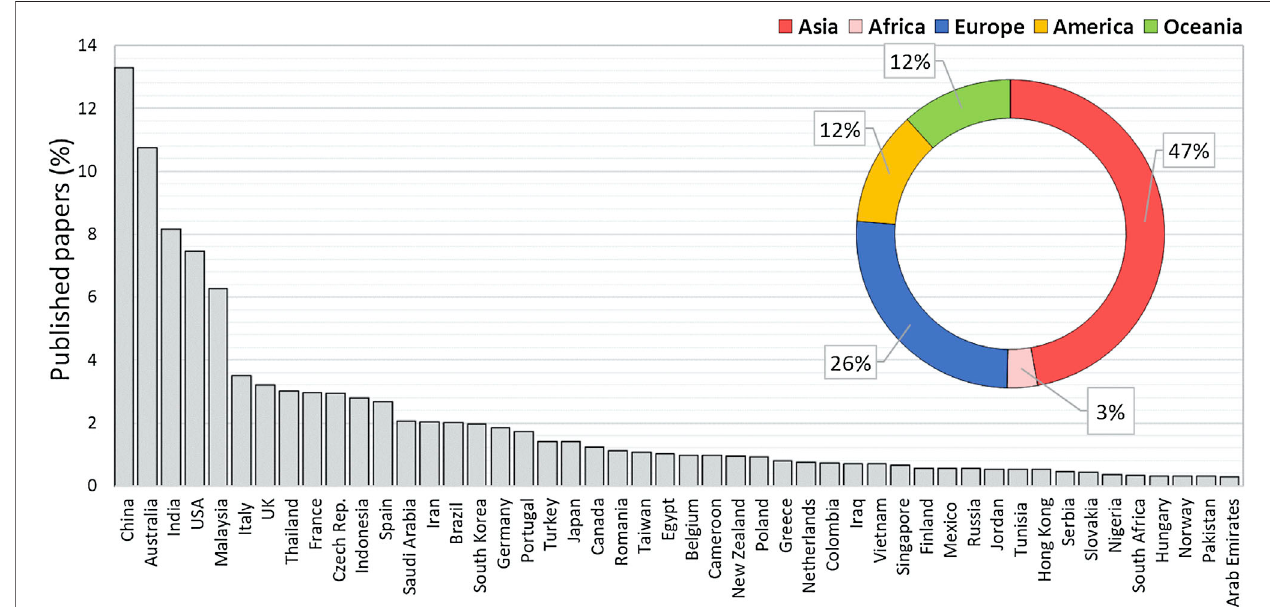
FIGURE 2 | Geographical distribution of the published works (2009 – 2019) on the speci fi c topic of alkali-activated materials and geopolymers: representation of country-based and continent-based distribution.